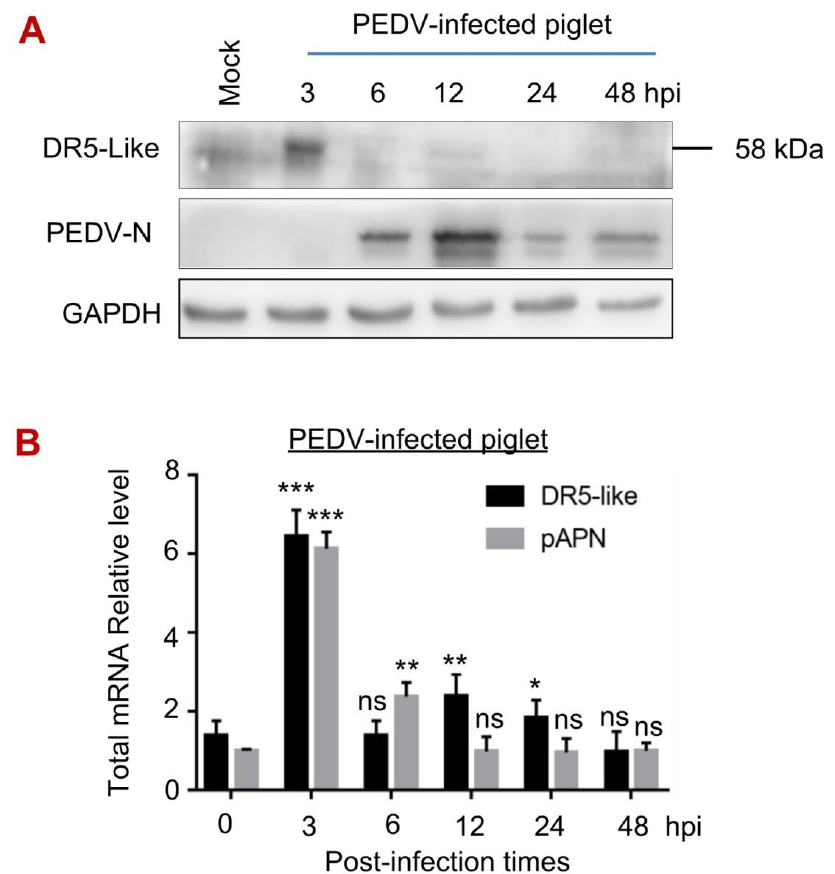
Figure 5. Levels of DR5-like mRNA and proteins in jejunum of piglets during PEDV infection. ( A , B ), Piglets were challenged with 10 5 TCID 50 PEDV or DMEM in 3 mL for different times, and the jejunum was obtained. The protein level was analyzed by Western blot with the indicated antibodies and mRNA level of DR5-like was analyzed by RT-qPCR. *, p < 0.05; **, p < 0.01; ***, p < 0.001; ns p > 0.05.